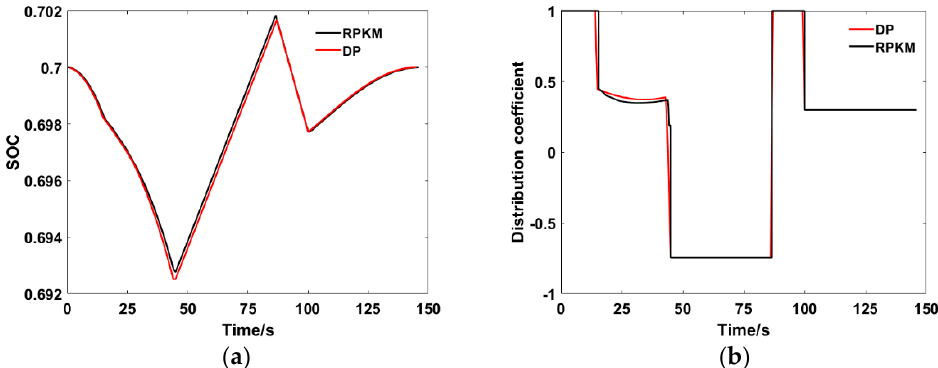
Figure 11. Comparison of optimization results between DP and RPKM: ( a ) SOC, ( b ) Distribution coefficient.